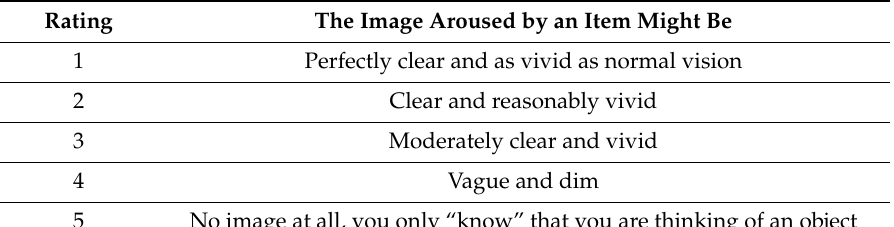
Table 1. The rating scale in the Vividness of Visual Imagery Questionnaire [4].